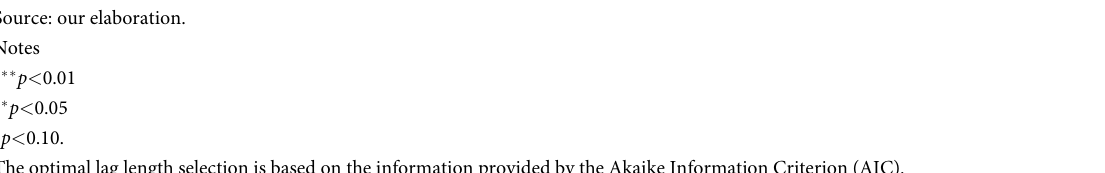
p- Results for the Half- Wald test statistic value Panel Jackknife estimator Coefficient p-